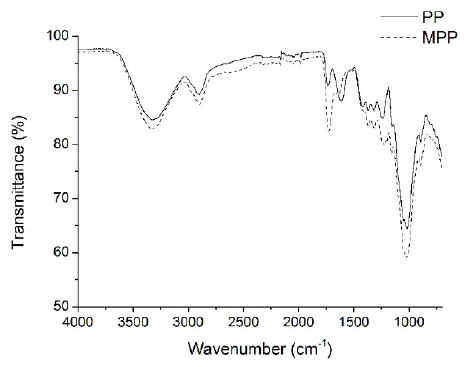
Figure 1. FTIR of the PPL and MPPL.